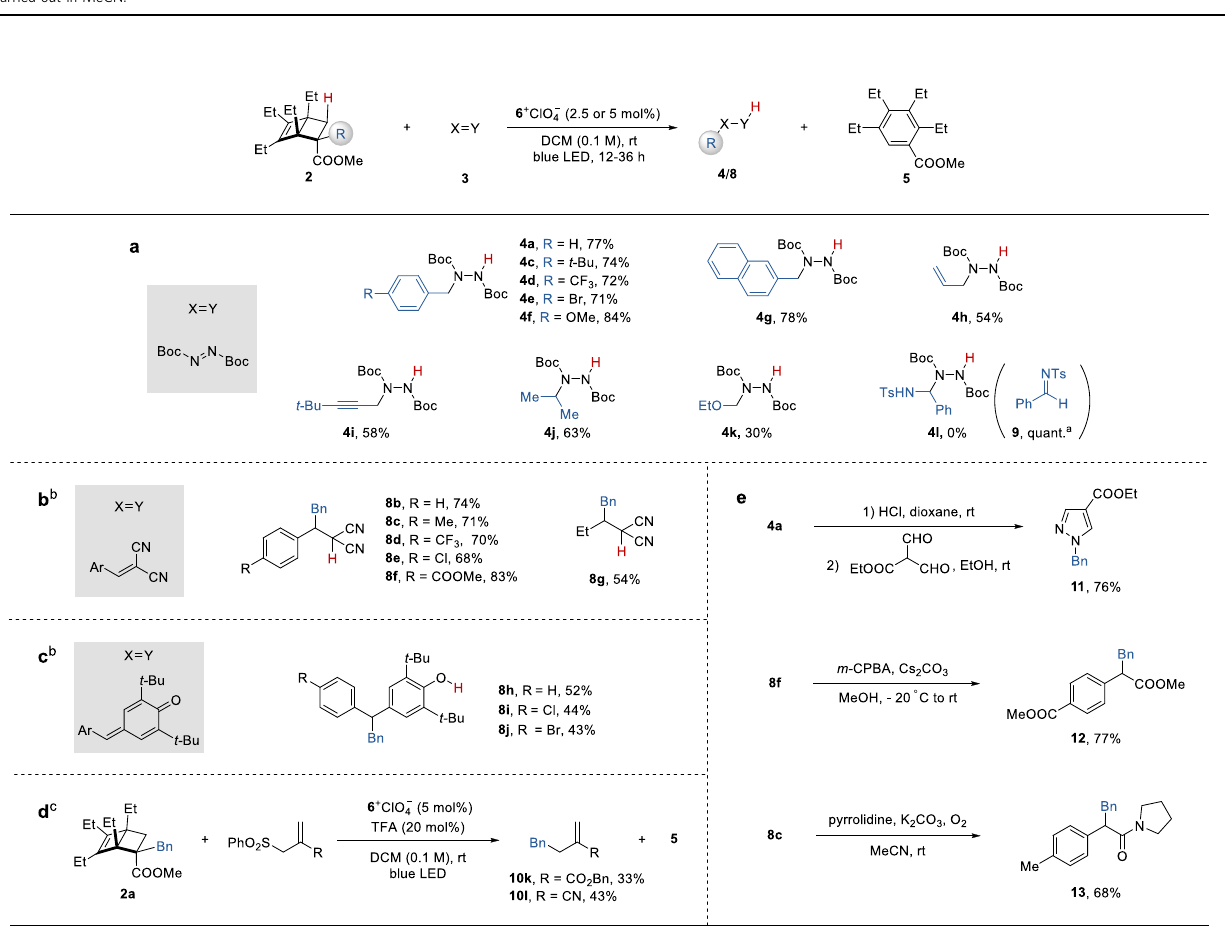
Fig. 3 Evaluation of BCHs as alkyl radical donors and derivatization of alkylation products. a Scope of alkylated BCHs. b – d Scope of radical acceptors. e Derivatization of alkylation products. Standard conditions: 2 (0.20 mmol), 3 (0.40 mmol), 6 (2.5 or 5 mol%), in 2.0 mL DCM at room temperature under blue light irradiation (450 nm) for 12 – 36 h. Yields refer to isolated yields after chromatography. a Determined by 1 H NMR using an internal standard. b In the presence of 20 mol% TFA. c Carried out at a 0.10 mmol scale.